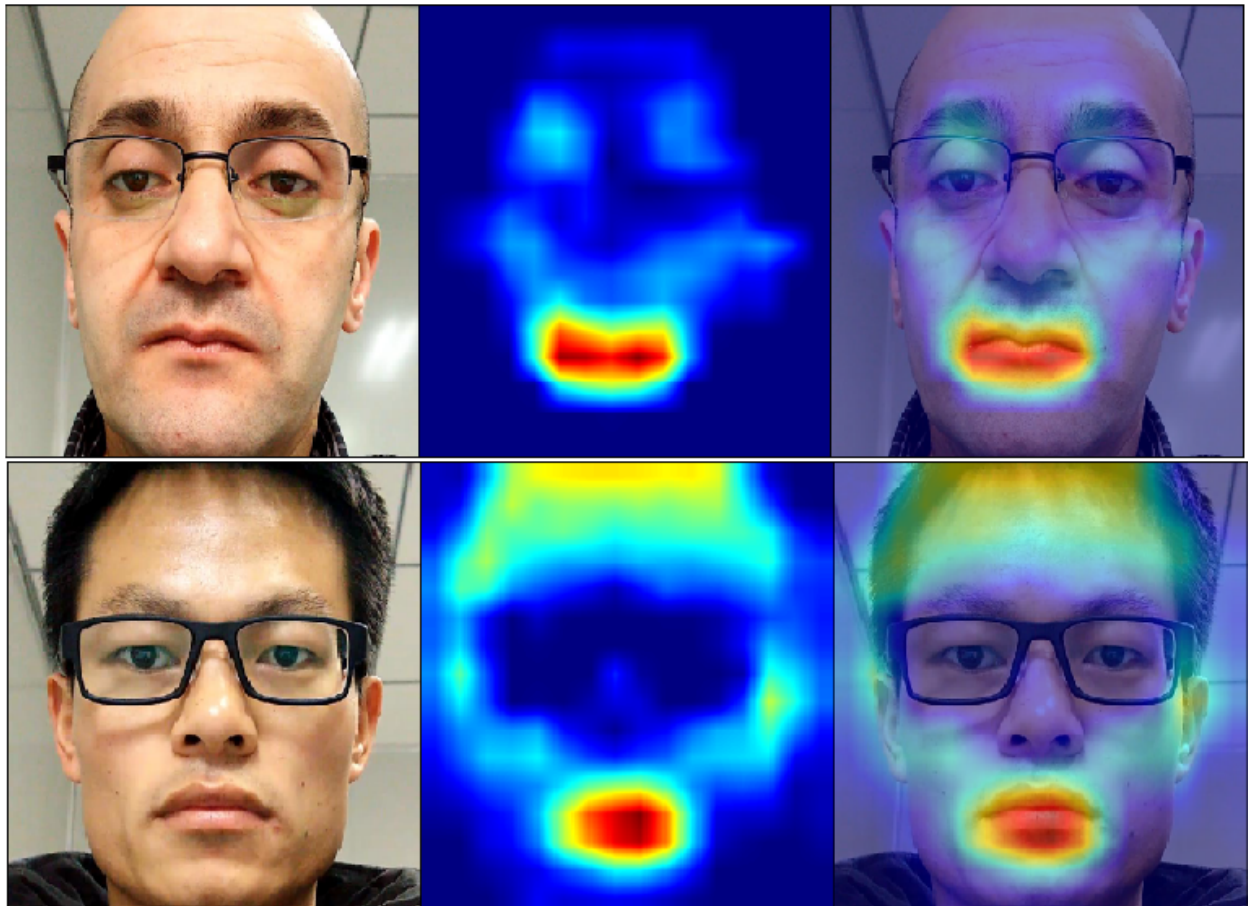
Figure 8. GRAD-CAM [53] visualizations of the last pyramid layer of the Bi-FAS-S model on the incorrect bonafide